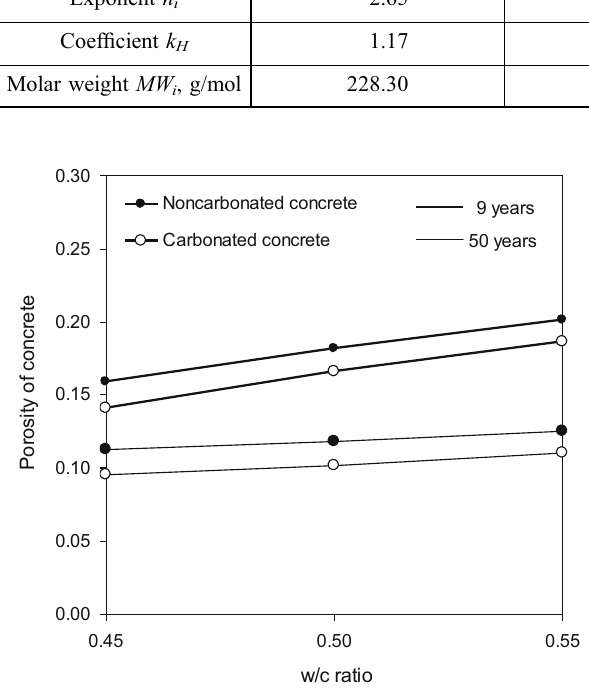
Fig. 4 Dependence of porosity of (non)carbonated concrete on time and water-cement ratio.